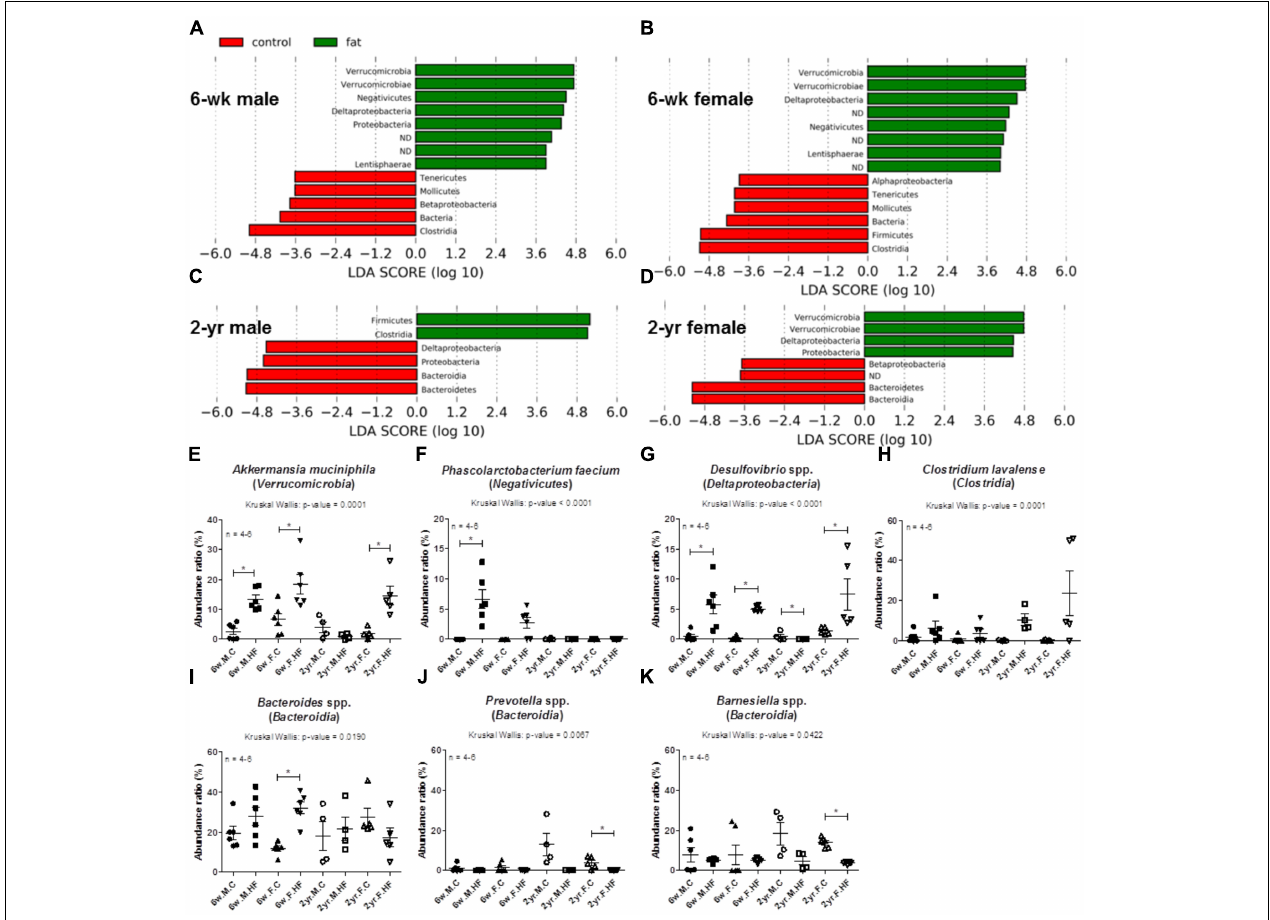
FIGURE 4 | Alterations in the abundance ratio of classes and major species following exposure to high-fat diet. LDA effect size (LEfSe) analyses compared the alterations in microbiome according to the diet at the class level. Negative LDA scores (red) are enriched in controls and positive LDA scores (green) are enriched in high-fat diet groups of 6-week-old male (A) , 6-week-old female (B) , 2-year-old male (C) , and 2-year-old female (D) . Abundance ratios (%) of Akkermansia muciniphila (E) , Phascolarctobacterium faecium (F) , Desulfovibrio spp. (G) , Clostridium lavalense (H) , Bacteroides spp. (I) , Prevotella spp. (J) , and Barnesiella spp. (K) were analyzed according to diet and age. Scatter plot (mean, SEM) (6-week-old rats, n = 6; 2-year-old male rats, n = 4; 2-year-old female rats, n = 5); p -values to Kruskal–Wallis test is designated on the figure; ∗ p < 0.05 according to Mann–Whitney U -test with Holm–Bonferroni correction; 6w, 6-week-old; 2yr, 2-year-old; M, male; F, female; C, control; HF, high-fat diet.